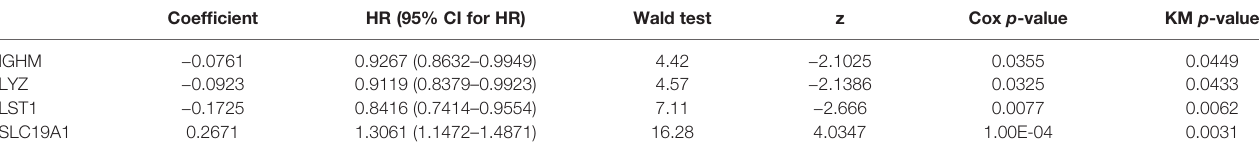
TABLE 2 | Hypoxia-immune-related genes in K-M curve and univariate Cox regression analysis. Coef fi